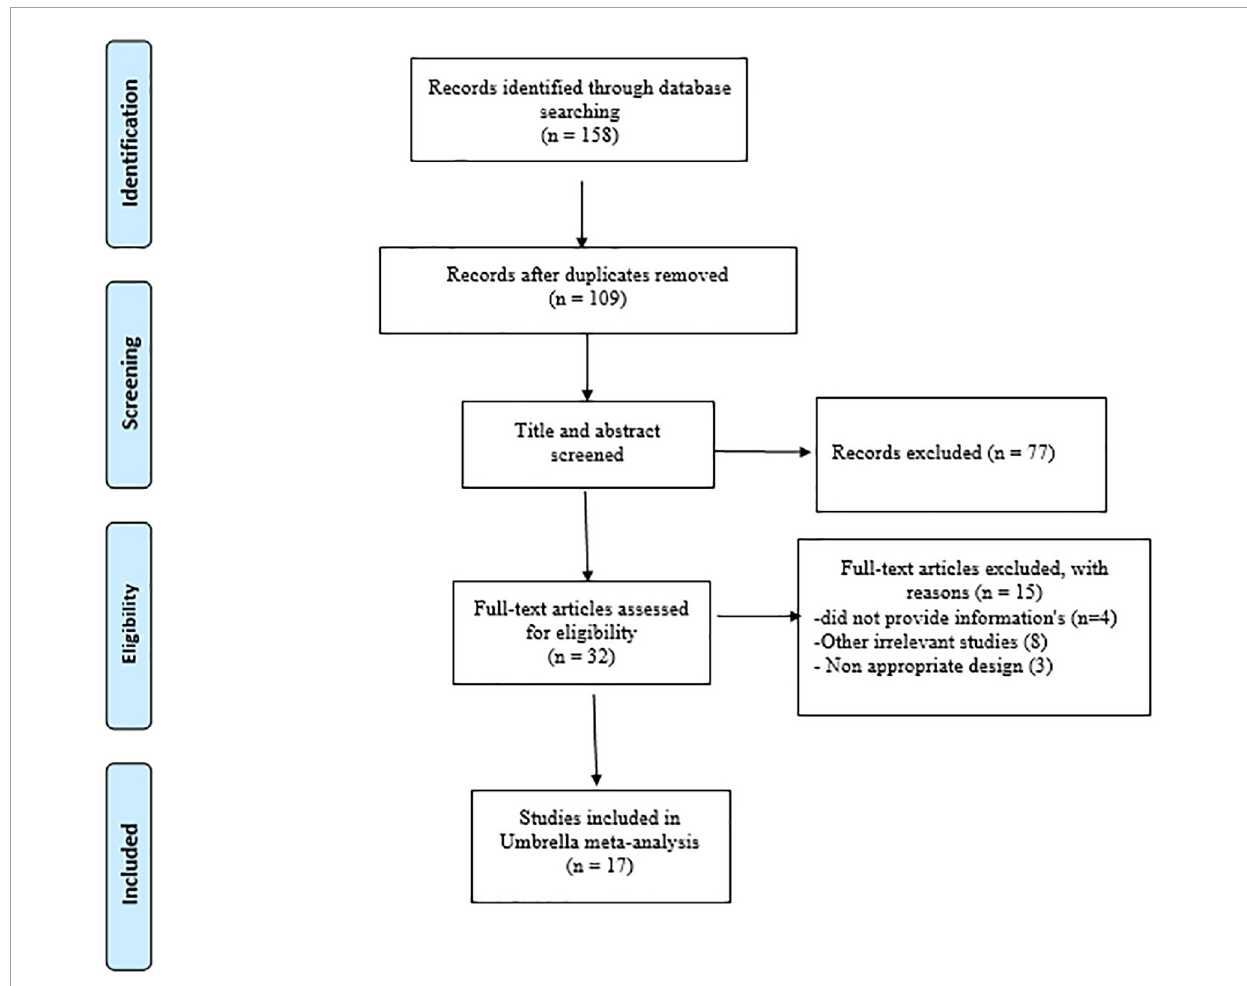
FIGURE1 PRISMA flow diagram of selection